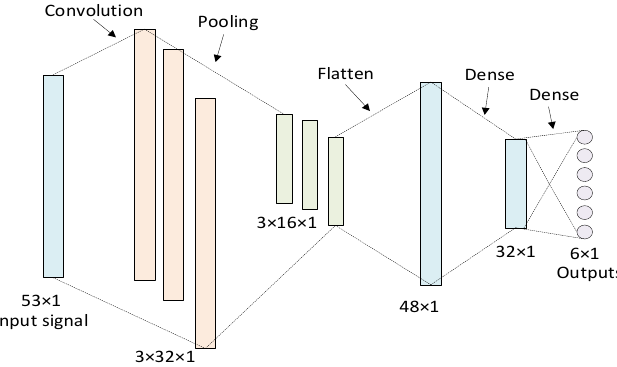
Figure 3. Training model of local convolutional neural network.